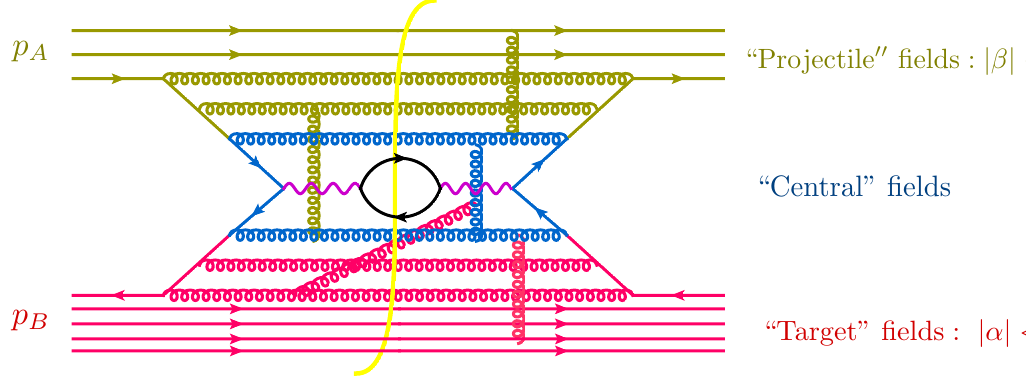
Figure 2 . Rapidity factorization for DY particle